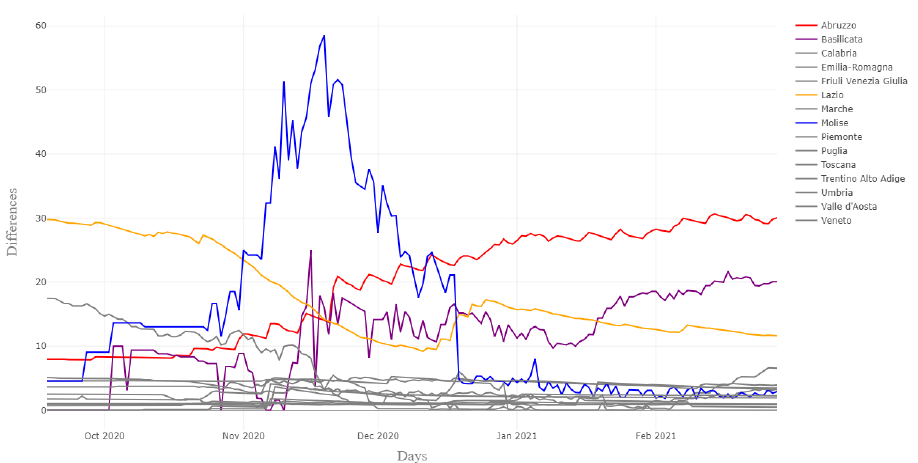
Figure 1. Official and retrieved data